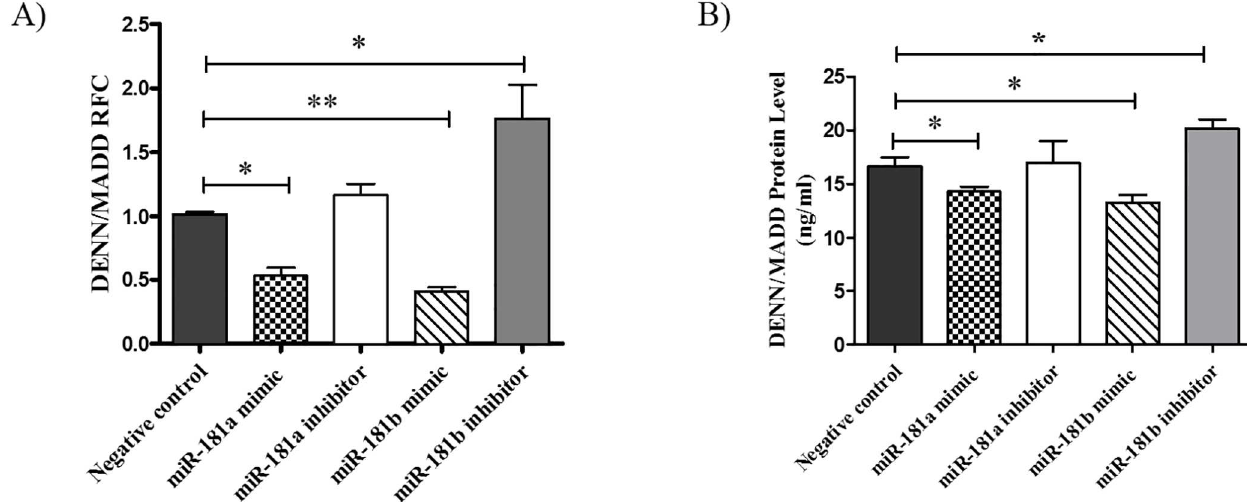
Fig 3. miR-181overexpression down-regulates endogenous MADD expression. L929 cells were transfected with miR-181a,miR-181b mimics, inhibitors and negative control (50nM) for 24 or 48 hours. Cells were also treated with TNF- α (50ng/ml) for 30 minutes after transfection. mRNA expressionA) protein level B) of DENN/MADD in transfected cells are shown by RT-PCR and ELISA, respectively.Data are shown as means ± SEM. (n = 3) Kruskal wallis & ANOVA, Tukey post hoc ( * p < 0.05, ** p < 0.01,relativeto negativecontrol).